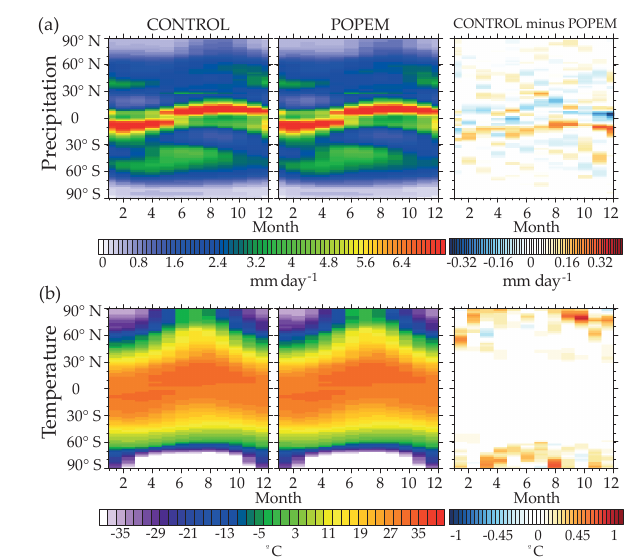
Figure 5. Latitude vs. time plots for precipitation (a) and surface temperature (b) . For absolute difference graphs, blue represents higher values in POPEM and red represents higher values in the CONTROL. Units are in mmday − 1 for precipitation and in ◦ C for